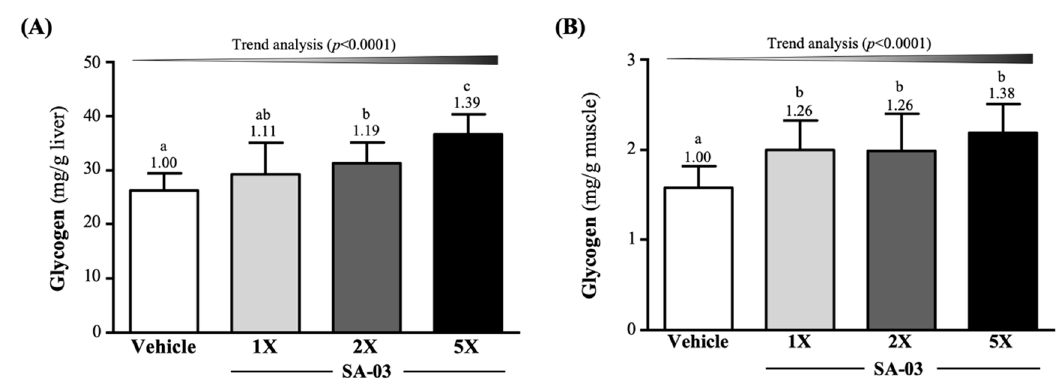
Figure 6. Effect of 4 weeks of SA-03 supplementation on ( A ) hepatic and ( B ) muscle glycogen levels. Data are expressed as mean ± SD for n = 10 mice per group. Values with different superscript letters (a, b, c) are significantly different at p < 0.05. Table 3. E ff ects of SA-03 on biochemical